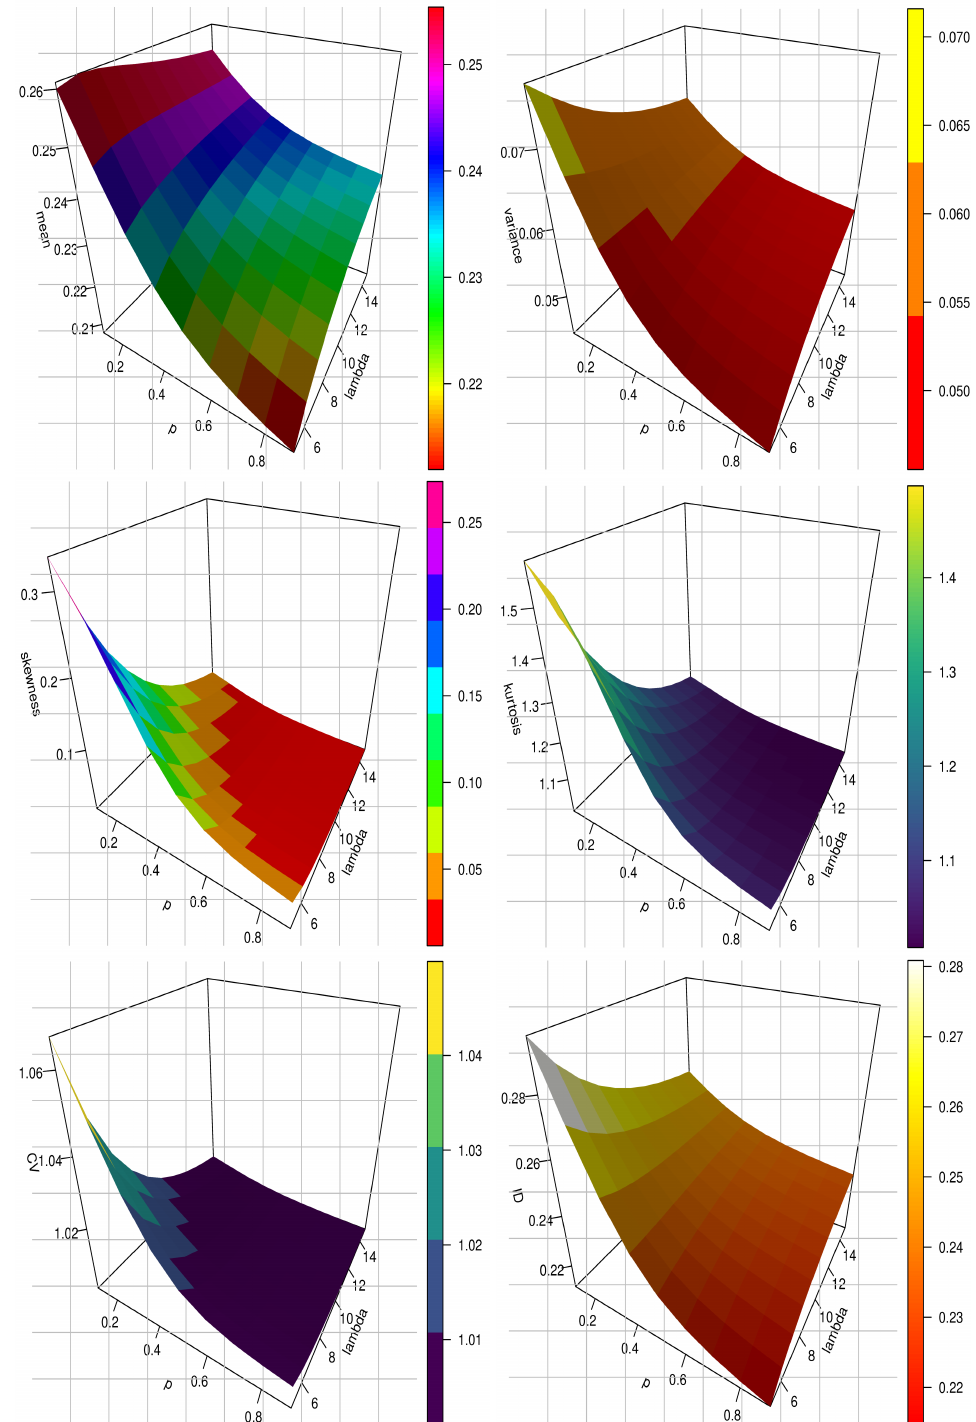
Figure 10. Three-dimensional plots of the mean, variance, CS, CK, CV and ID for FB model at p ∈ [ 0,1 ] , λ ∈ [ 5,15 ] and n =